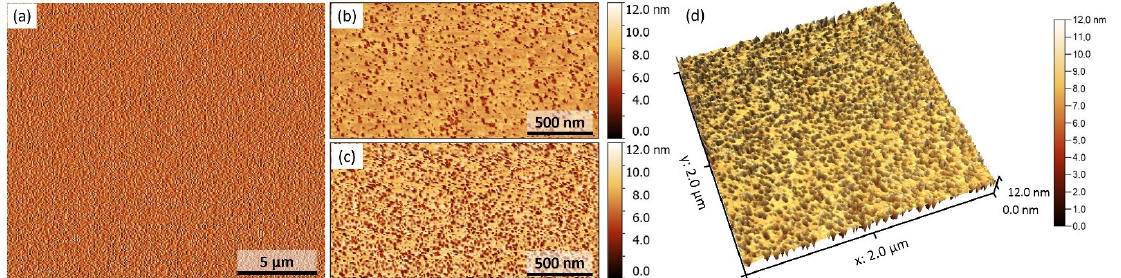
Figure 7. AFM images of the surface of Fe 3+ x Si 1 − x /Ge/Fe 3+ x Si 1 − x /Si(111) films. ( a ) A typical depiction of surface topology for sample #7; ( b ) for sample #6; ( c ) for sample #7; and ( d ) 3-d surface topology view for sample #6.